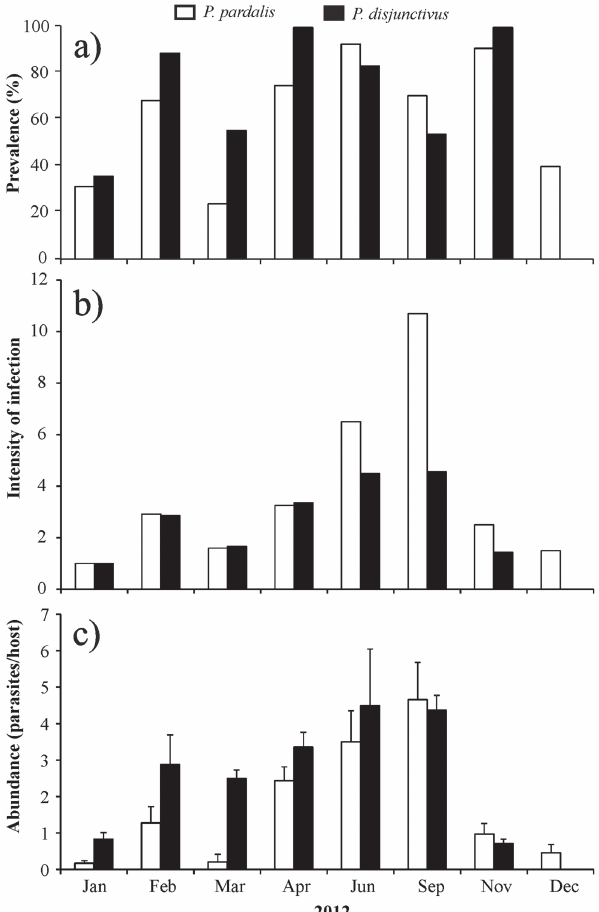
Fig.1. Intra-annual variations in: a) prevalence, b) intensity of infection and c) abundance of parasites in the invasive loricarids Pterygoplichthys disjunctivus and P . pardalis from a freshwater ecosystem of southeastern Mexico.